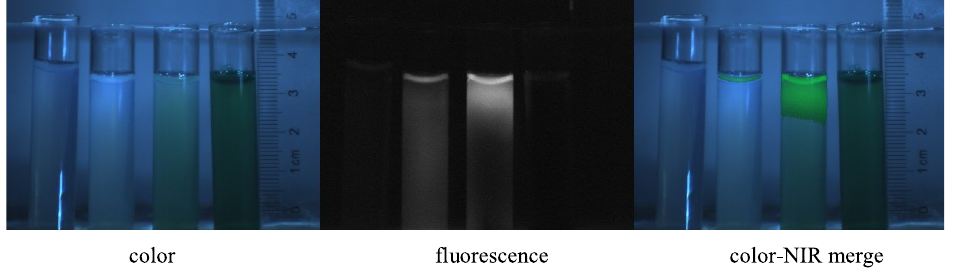
Fig. 4. Penetration depth images of di®erent ICG concentrations (test tube from left to right: 0 (cid:1) mol/L, 1.64 (cid:1) mol/L, 13.11 (cid:1) mol/L, 104.85 (cid:1) mol/L).